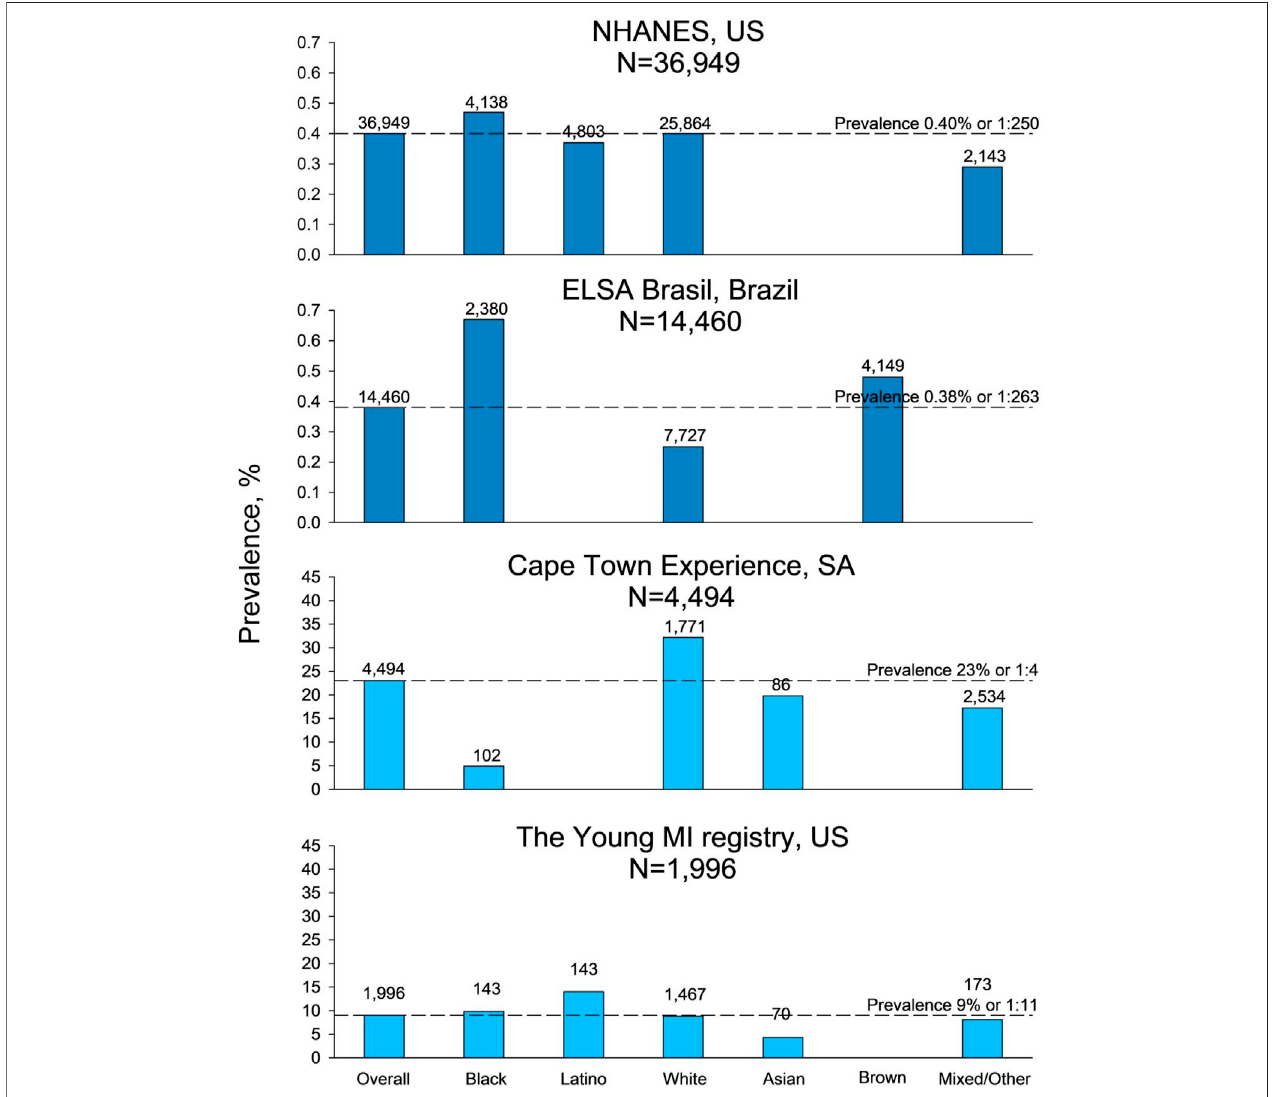
FIGURE 2 | Prevalence of familial hypercholesterolemia in studies including more than two ethnicities. Prevalence shown with dark blue bars is from general population studies, and prevalence shown with light blue bars is from patient cohort studies. For information on ethnicity, refer to Methods. N, number of participants in the study, US, United States of America, SA, South